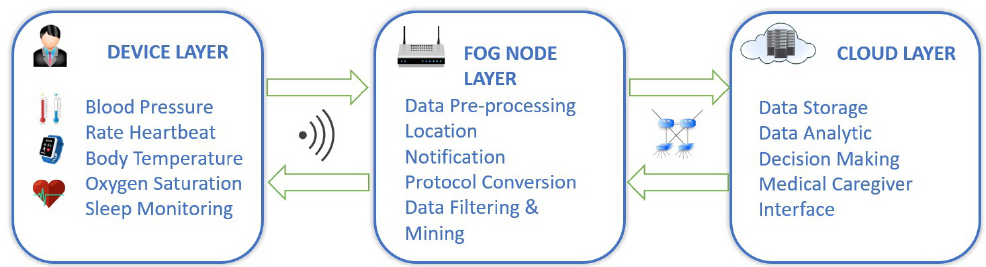
Figure 1. IoT based fog-driven health monitoring system.